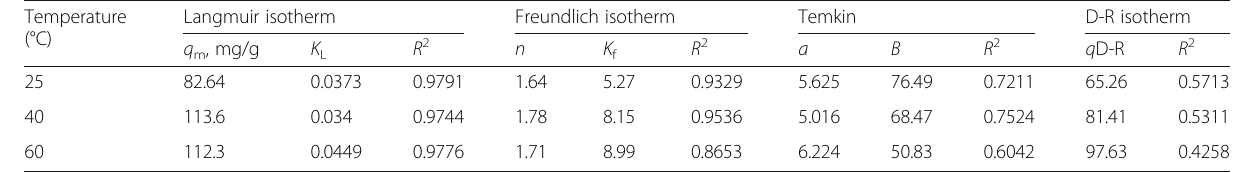
Table 2 Summary of the constants of different kinetic models for adsorption of AO67onto RPSF at different concentrations and different temperatures Temperature Langmuir isotherm (°C)